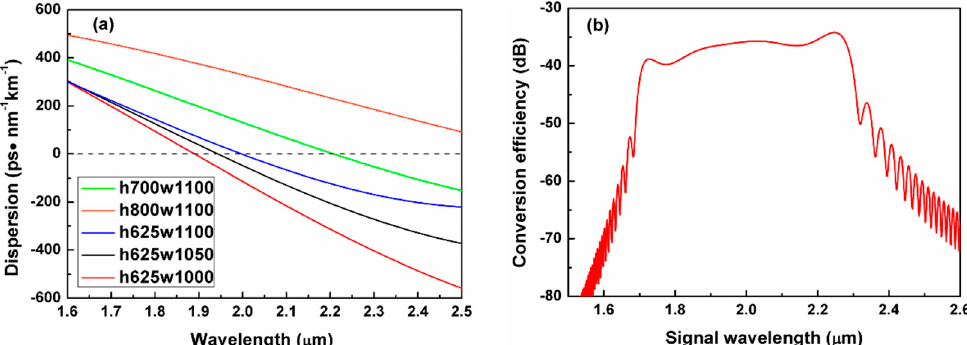
Figure 8. ( a ) Calculated wavelength dependence of the dispersion for the silicon-rich nitride ridge waveguides with various waveguide dimensions. ( b ) Calculated four-wave mixing conversion efficiency with respect to the signal wavelength for a SRN ridge waveguide ( h = 625 nm, w = 1050 nm) with the zero-dispersion wavelength at 1950 nm.